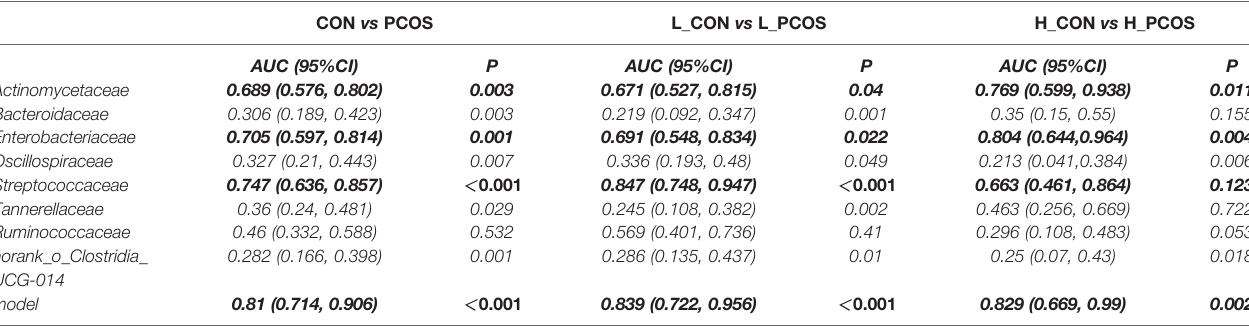
TABLE 3 | ROC correlation